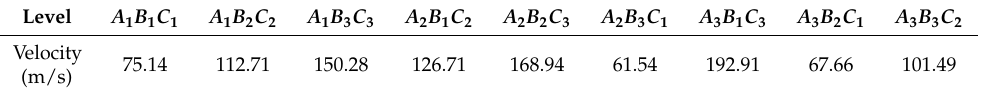
Table 3. Test conditions at maximum